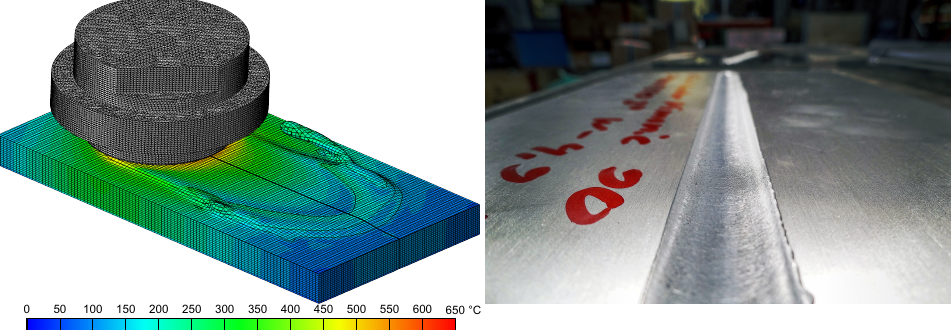
Figure 8. Outer appearance of weld carried out with the base geometry in simulation ( left ) and experiment ( right